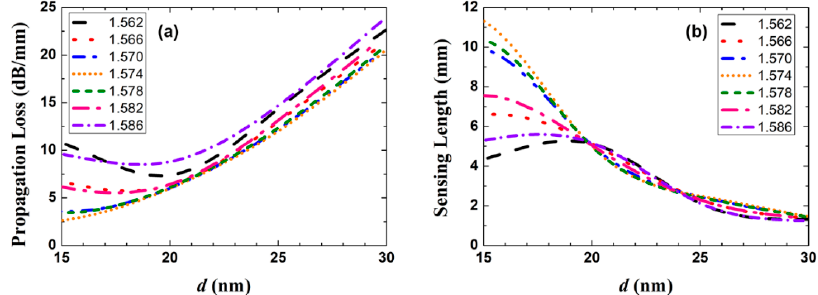
Figure 6. ( a ) Propagation loss (MPA a ) and ( b ) sensing length ( L a ) as a function of Au film thickness d for different n a , with the width of Au stripe set to 1.5 μ m.